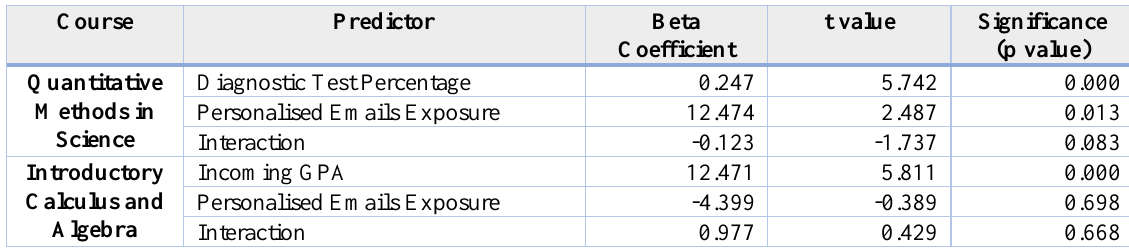
Results of Regression Analysis Predicting the Final Percentage in Each